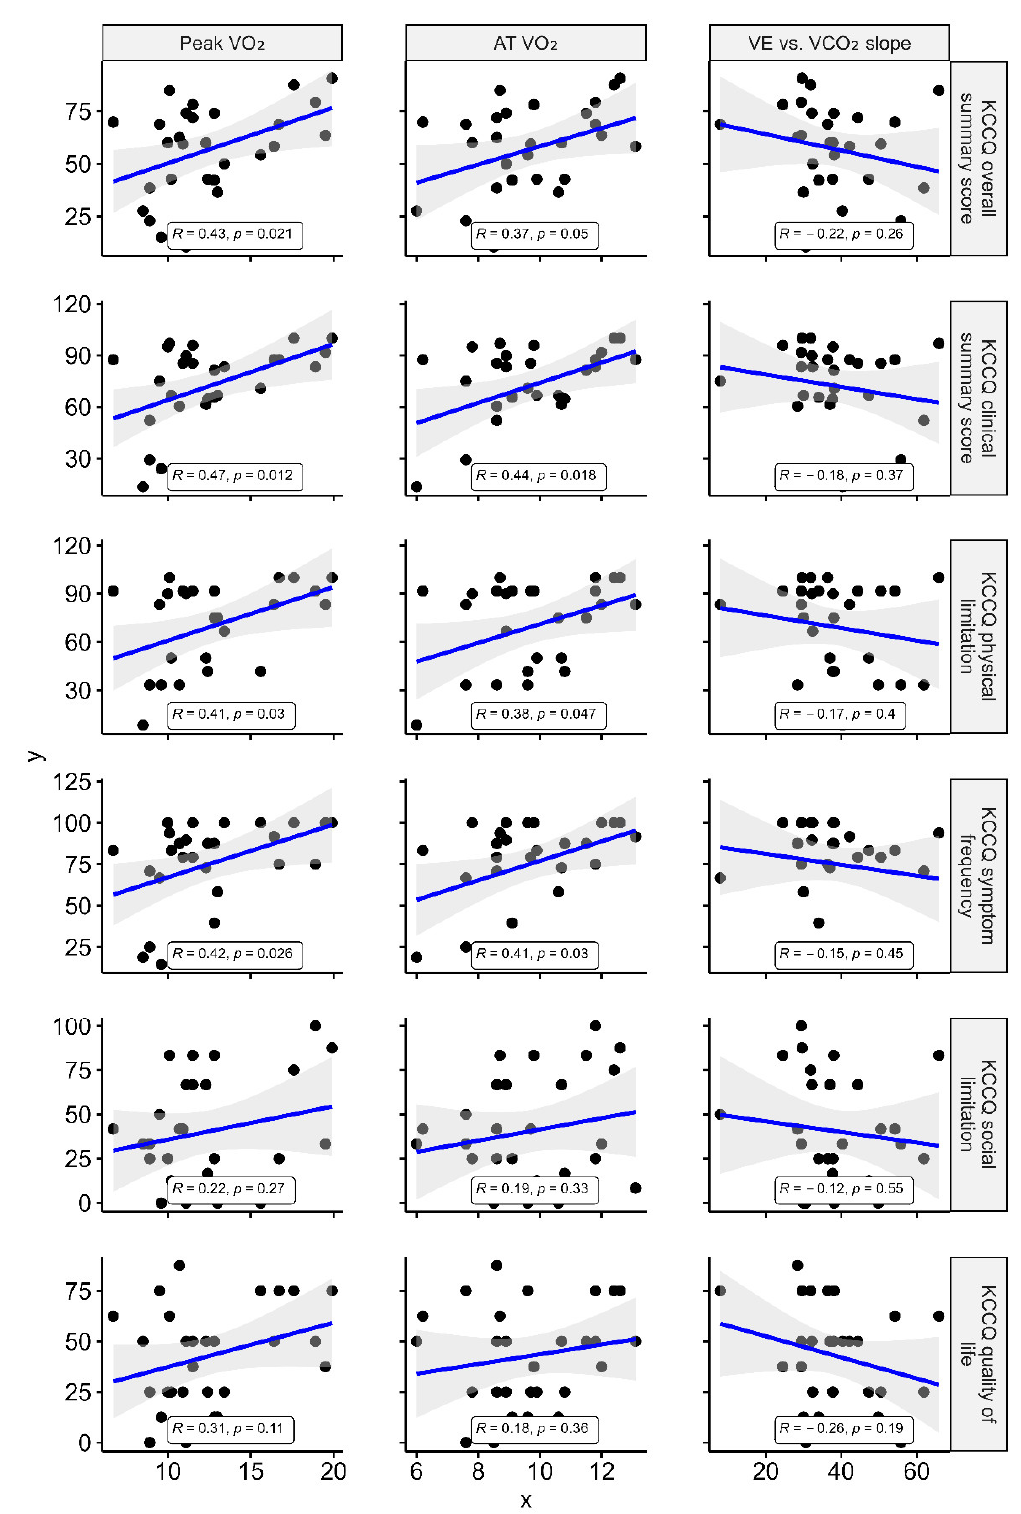
Figure 5. Correlation of CPX parameters with the Kansas City Cardiomyopathy Questionnaire. Caption: R represents Pearson’s correlation coefficient. KCCQ = Kansas City Cardiomyopathy Questionnaire; OSS = overall summary score; CSS = clinical summary score; VO 2 = oxygen consumption; VCO 2 = carbon dioxide production; VE = expiratory minute volume; AT = anaerobic threshold.